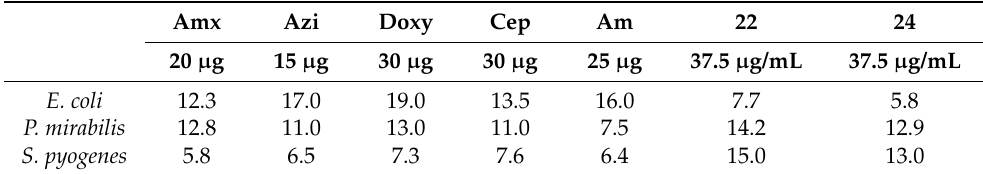
Table 3. Inhibition zone diameters (mm) of reference antibiotics and synthesized compounds 22